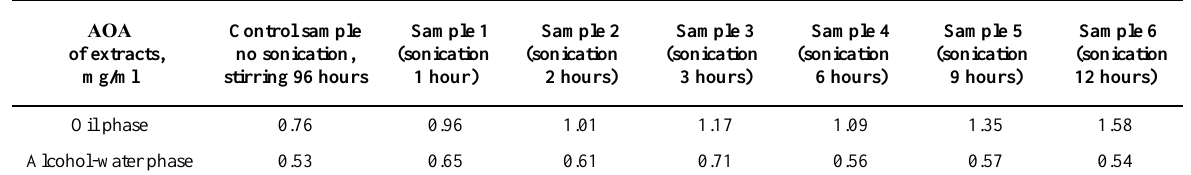
Table 1. Antioxidative activity (AOA) of BAS complexes from mussels in the oil phase and alcohol-water phase, depending on the ultrasonication time (in terms of the amount of biologically active substances with antioxidative properties, mg/ml) АОА of extracts,